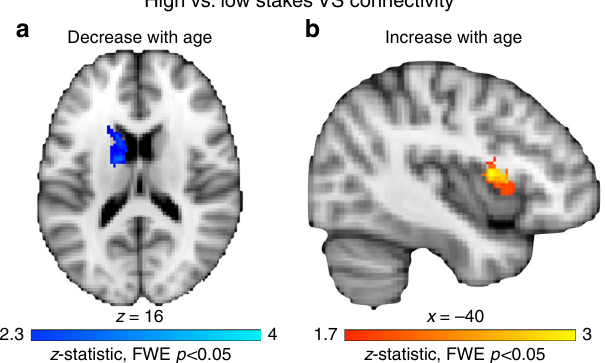
Fig. 4 PPI for high stakes versus low stakes targets as a function of decreasing and increasing age. a Striato – striato coupling decreases with age. PPI results for high stakes versus low stakes targets with a ventral striatum seed that decreases with age (whole-brain corrected t test, FWE p < 0.05). Ventral striatum – caudate coupling was enhanced for high stakes in the youngest participants and decreased linearly across development. b Corticostriatal coupling increases with age. PPI results for high stakes versus low stakes targets with a ventral striatum seed that increases with age (small volume corrected t test, FWE p < 0.05). Ventral striatum – vlPFC clusters survived correction for the left VS seed.